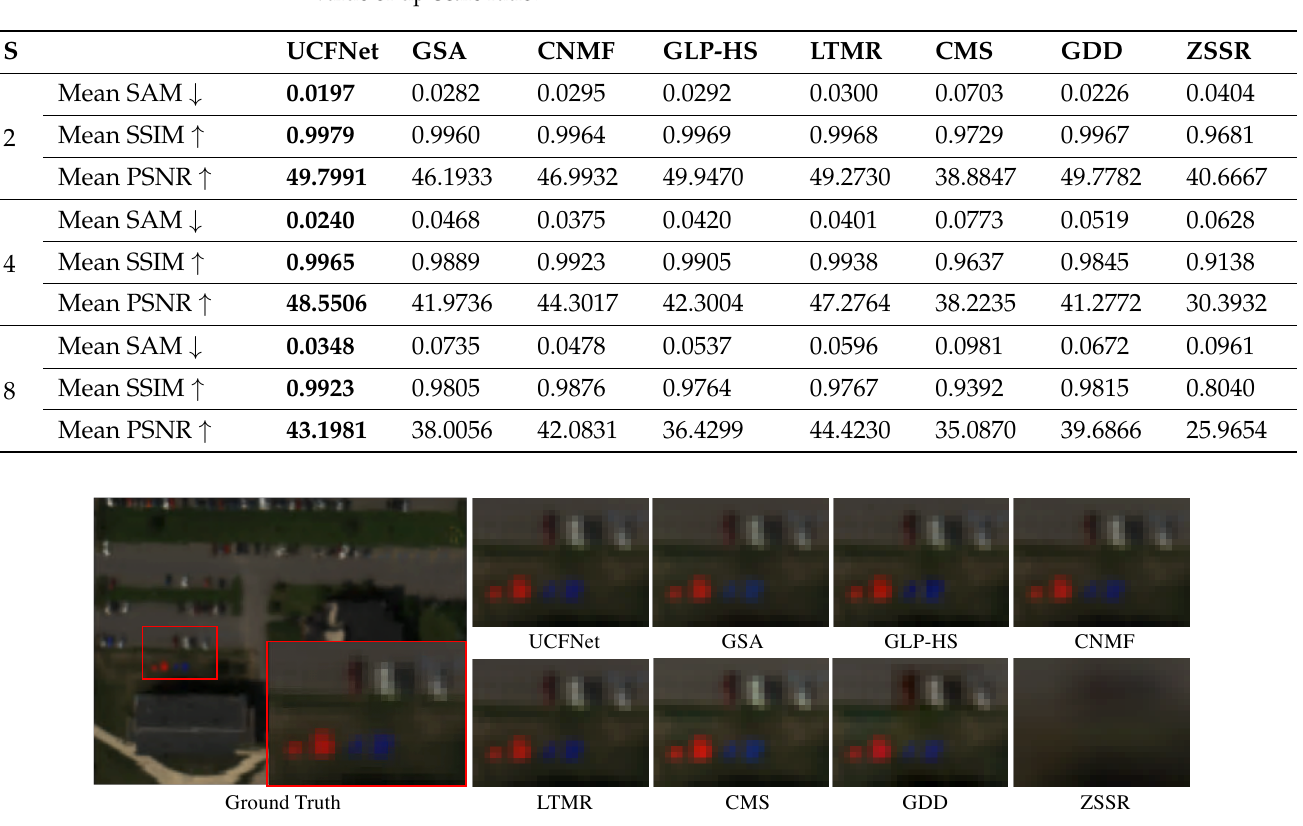
Table 3. Quantitative performance comparison of different algorithms on dataset SHARE-2010. The up-arrow means the higher the value, the better the performance. The down-arrow means the lower the value, the better the performance. The best performances are highlighted in bold. S represents the value of up-scale ratio.